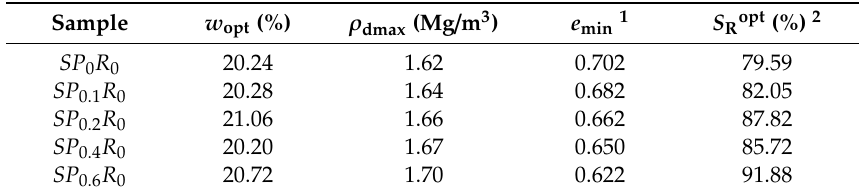
Table 6. Summary of the compaction characteristics for the natural soil and various PAM-treated